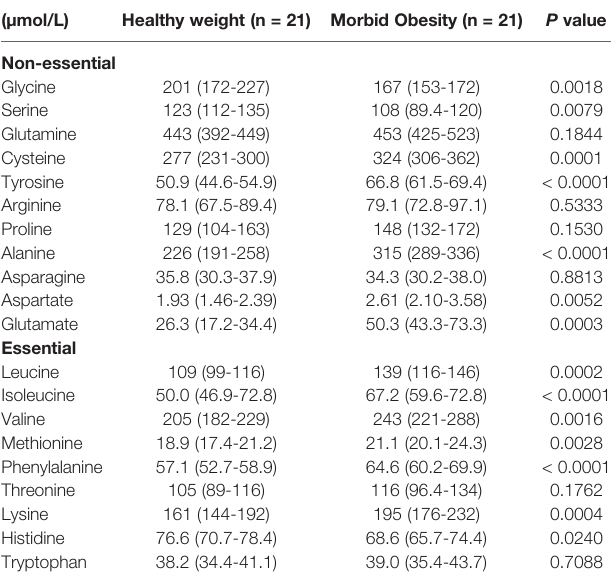
TABLE 4 | Plasma concentrations of amino acids in participants with healthy weight and with morbid obesity at baseline. (µmol/L) Healthy weight (n = 21) Morbid Obesity (n = 21) P value